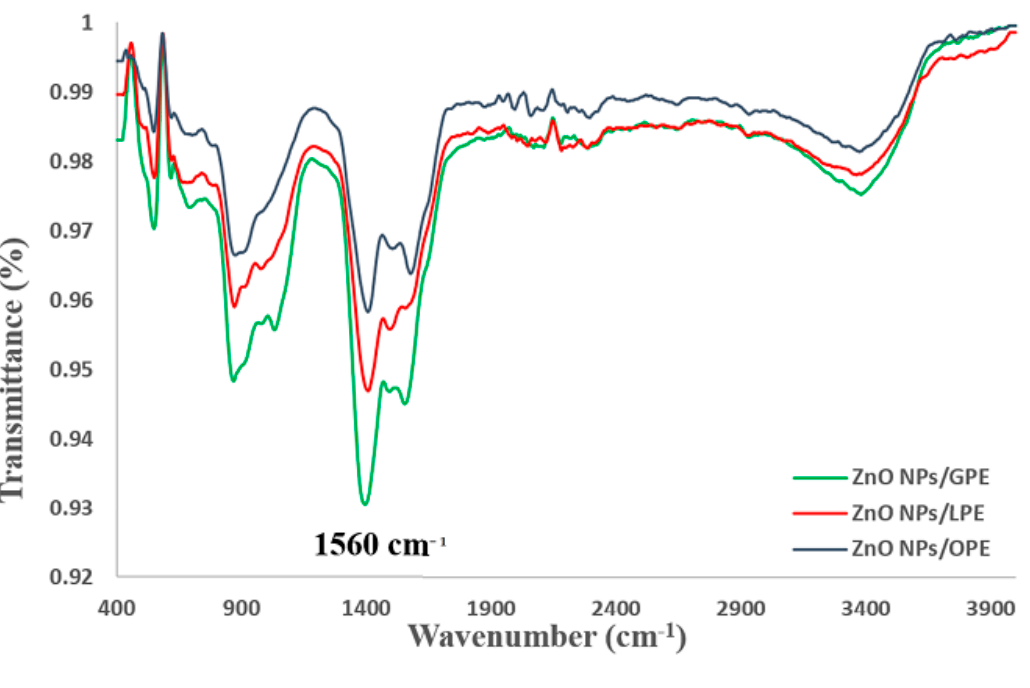
Figure 4. FTIR spectra of CPE /